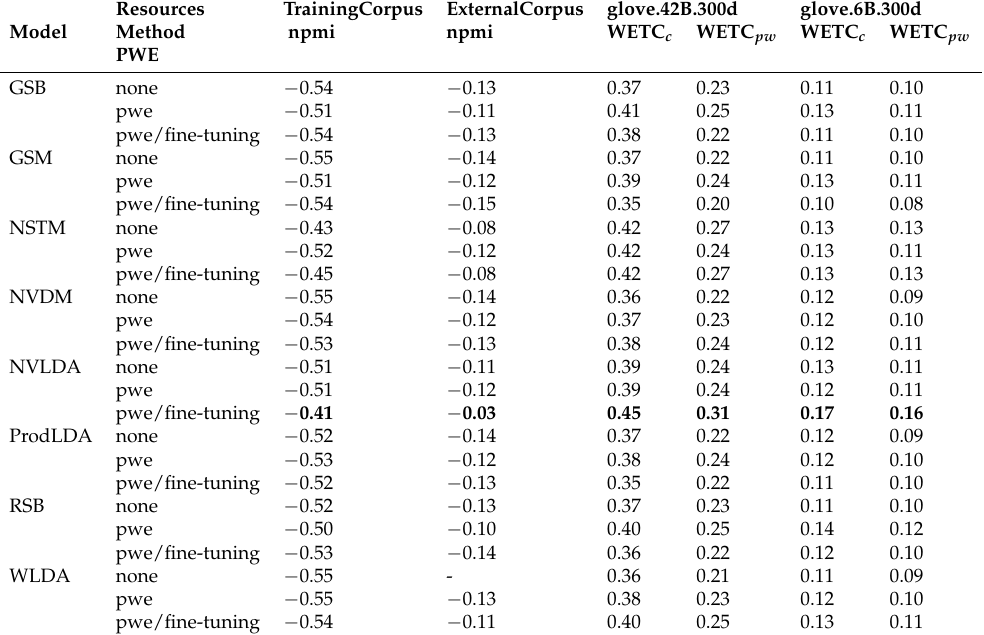
Table 8. Topic Coherence on M10.